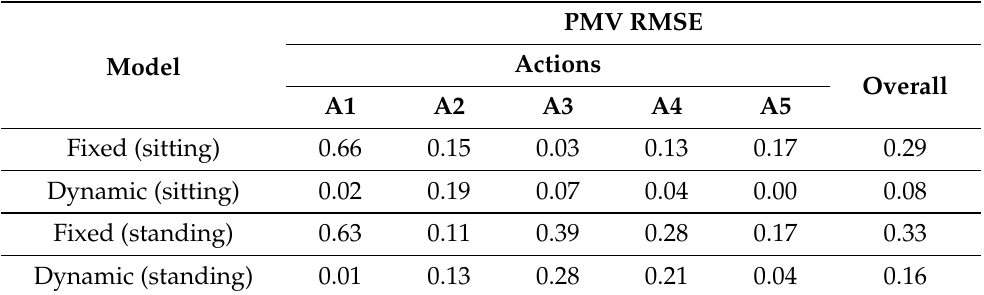
Table 4. PMV RMSE of the proposed and traditional models in terms of actions period and aver- age scenario.